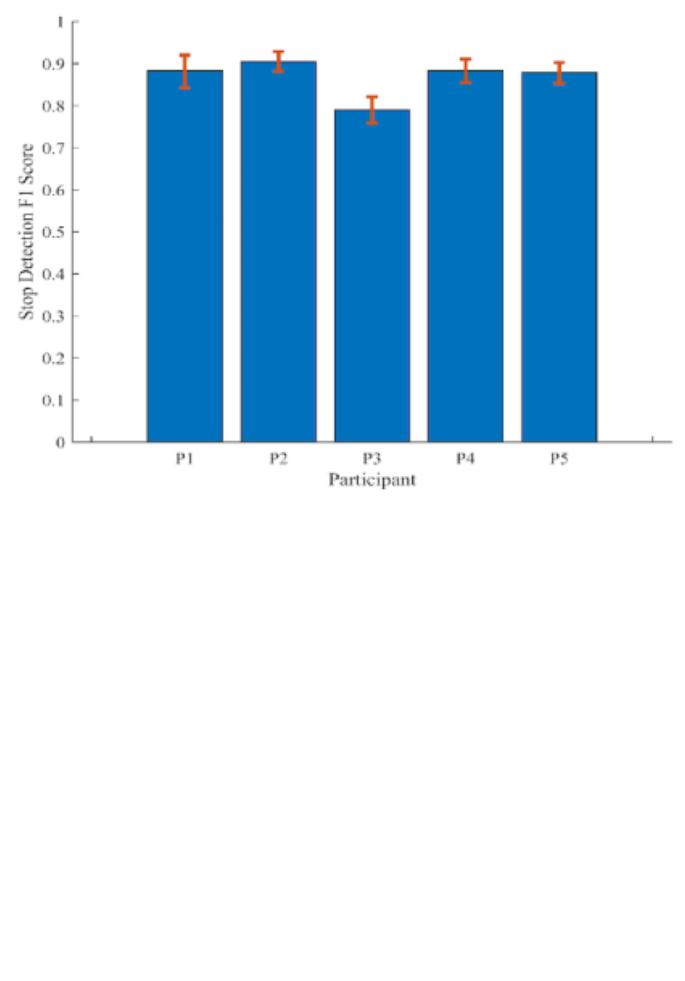
Figure 4. Stop-detection F1 scores for participants 1 to 5